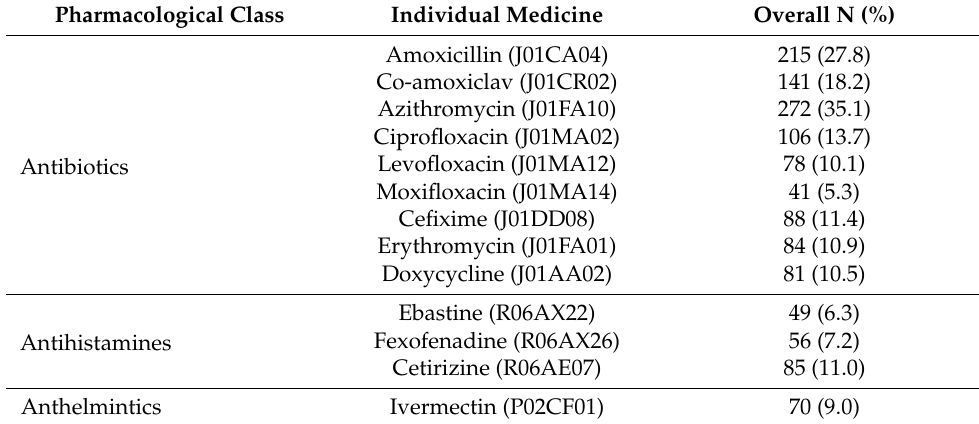
Figure 3. Pharmacological agents used for self-medication. NB: N = 774. Table 5. Medications self-administered to treat suspected